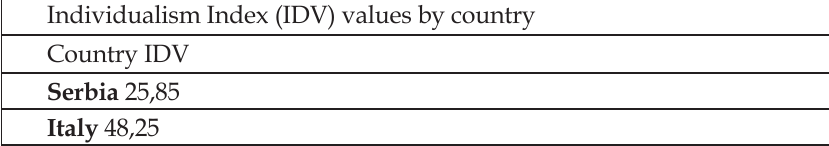
Table 4. Individualism Index (IDV) values by country. Individualism Index (IDV) values by country